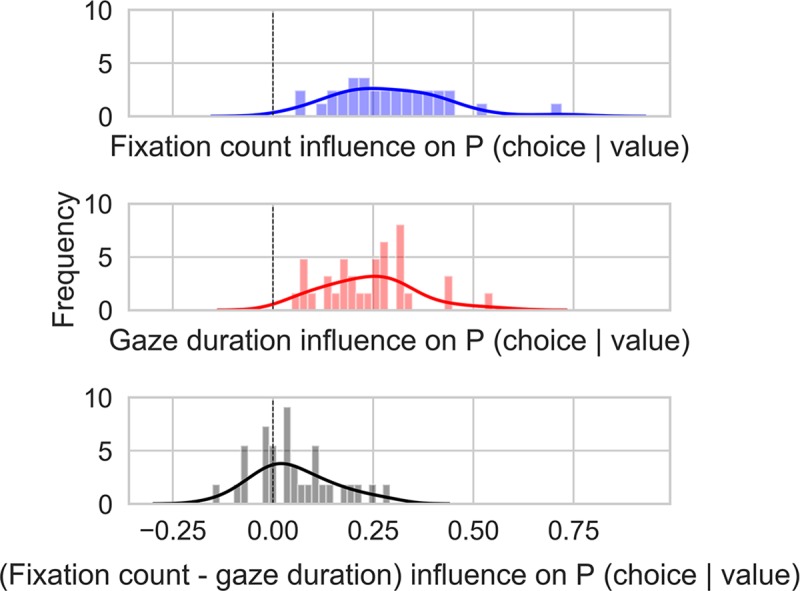
Gaze-influence on choice (after accounting for values), for the fixation count (upper panel; blue), for the total-gaze duration (middle panel; red) and their difference (lower panel; grey).